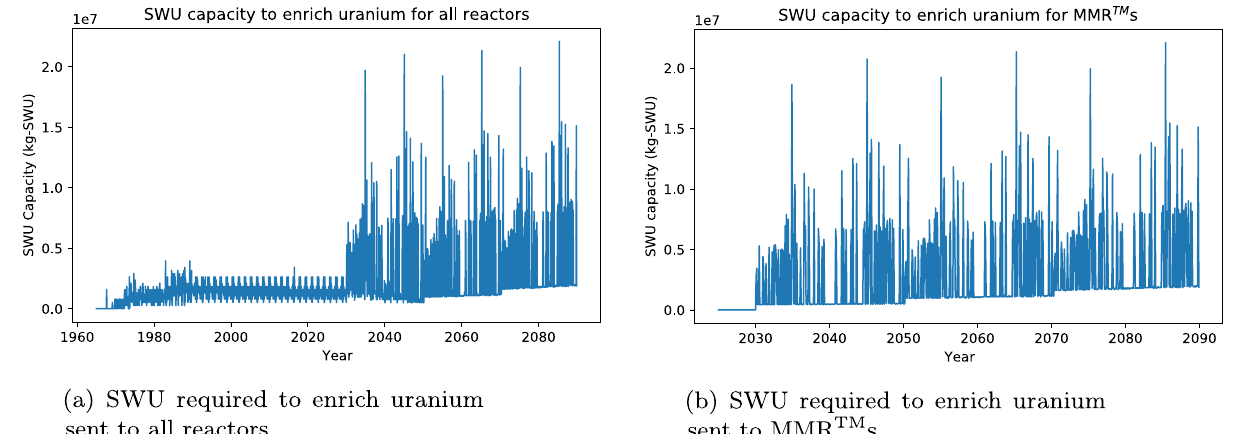
Fig. 13. SWU required to enrich natural uranium in Scenario 4.